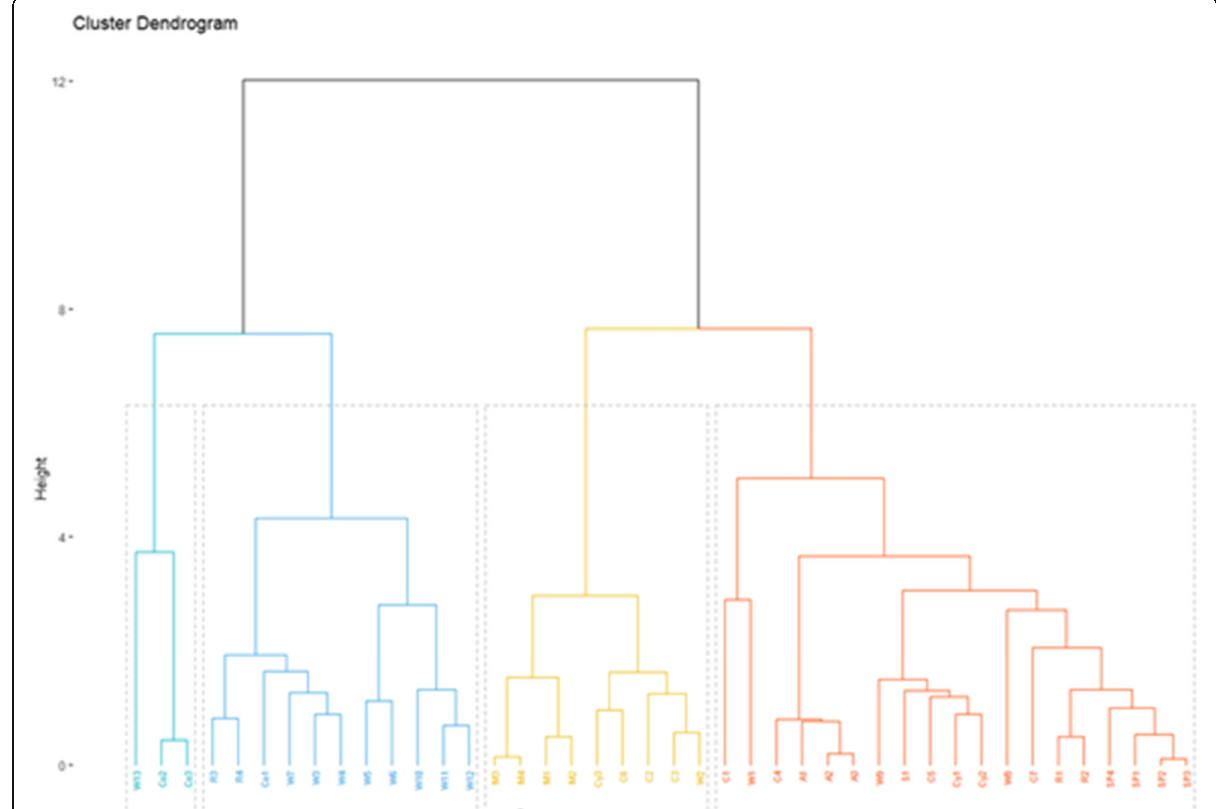
Fig. 3 Hierarchical ascending classification of proximate composition of 42